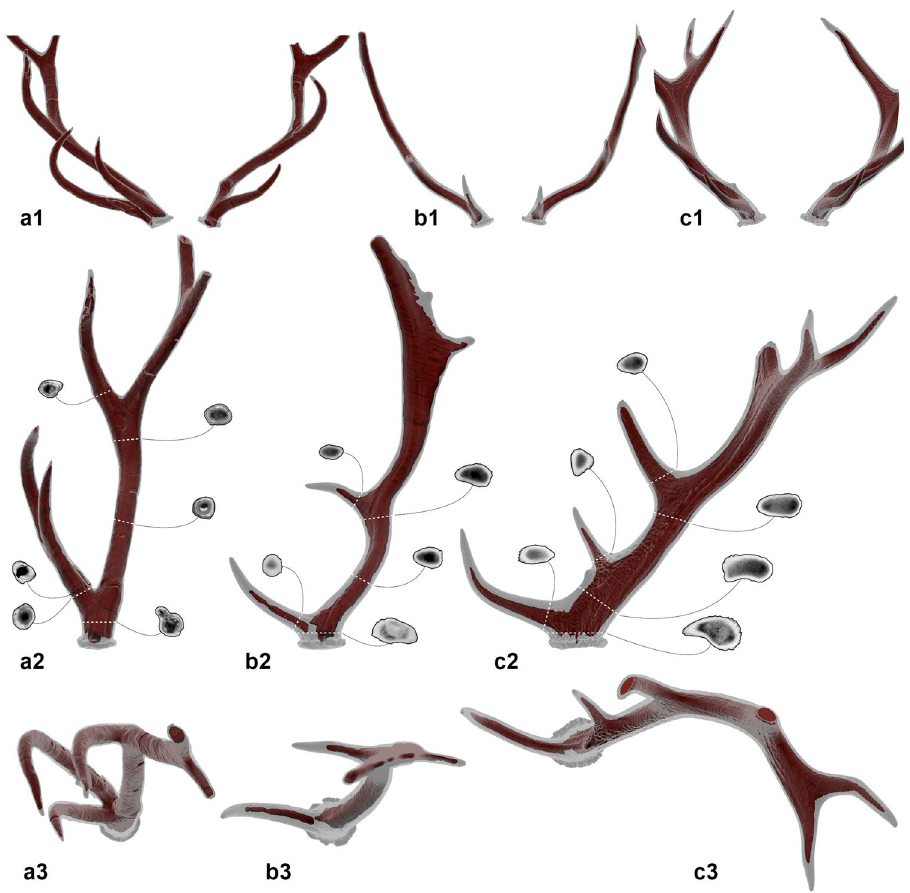
Figure 2. CT-based comparison of antler shape and cross-sections. ( a ) ‘Pseudodama’ nestii SABAP_UMB 337655; ( b ) Dama dama CZUFLD FaD002; ( c ) Cervus elaphus CZUFLD ReD001. Antler pairs in anterior ( a1–c1 ) view; right antler in medial ( a2–c2 ) and apical ( a3–c3 ) views. The internal structure of the antlers (spongious regions plus medullary cavities) is highlighted in dark red and through sections. All the images are